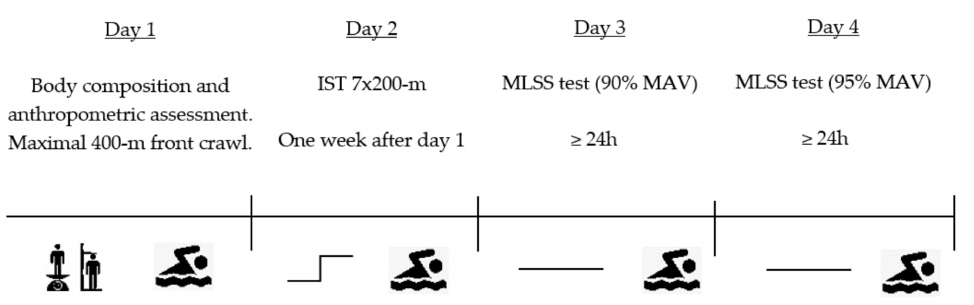
Figure 1. Schematic representation of the experimental protocol. IST, incremental step test; MLSS, maximal lactate steady state test (continuous test); MAV, maximal aerobic